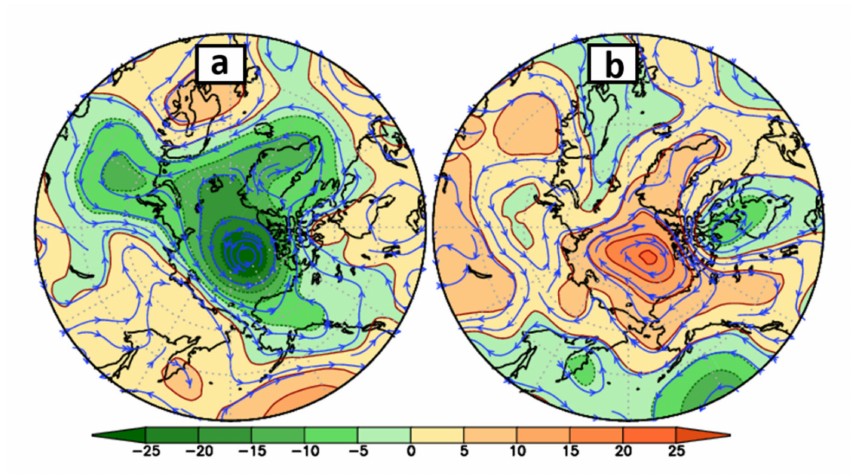
Figure 9. Composites of JJAS anomalies of 850 hPa geopotential height (m) (shaded) and streamlines ( a ) strong ISM years ( b ) weak ISM